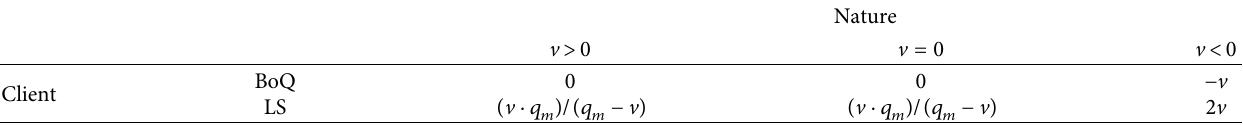
Table 2: The matrix of the equivalent